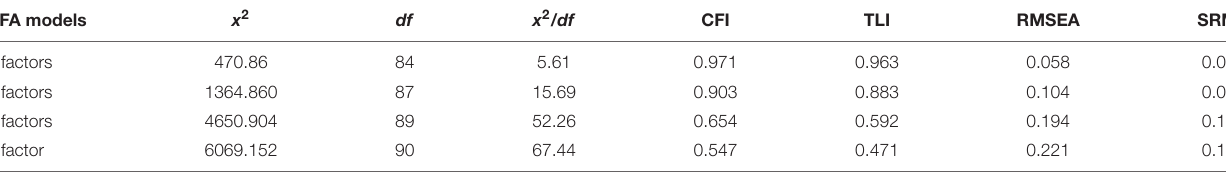
TABLE 2 | Testing the discriminant validity of the constructs. CFA